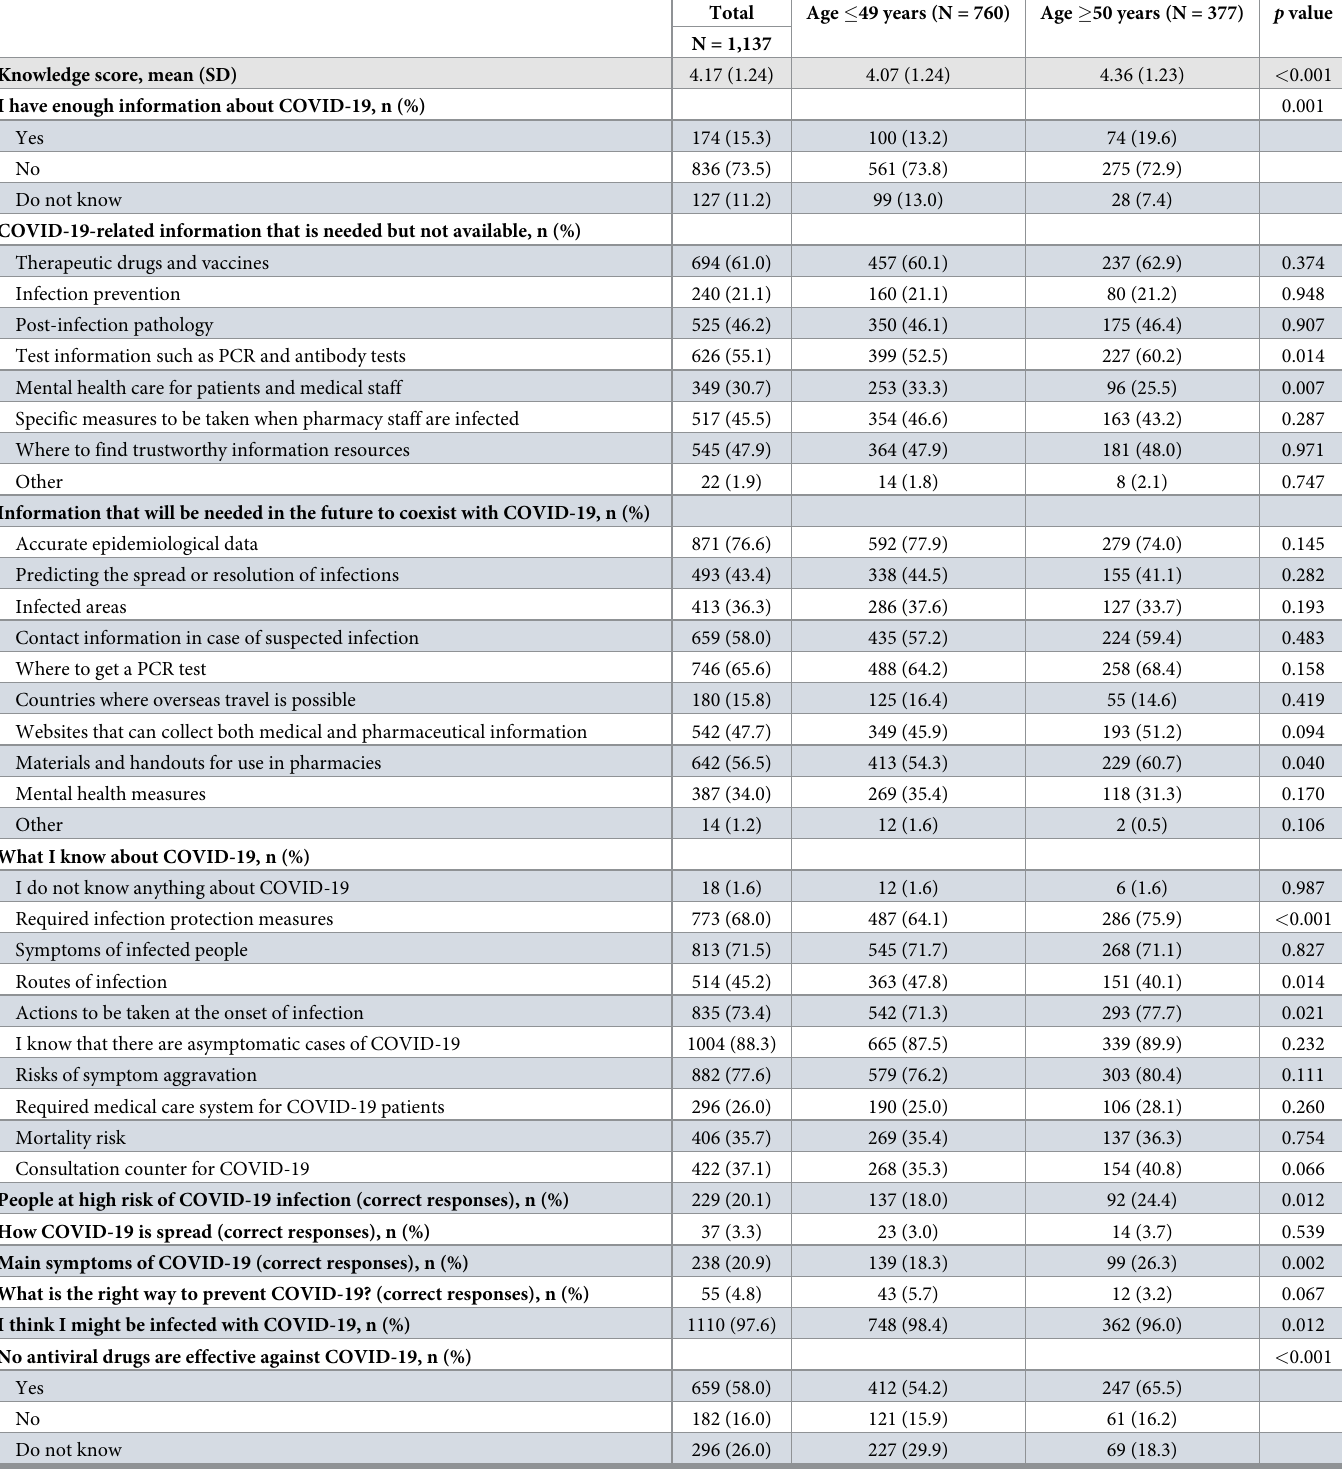
Table 2. Pharmacists’ responses regarding COVID-19-related knowledge, by age